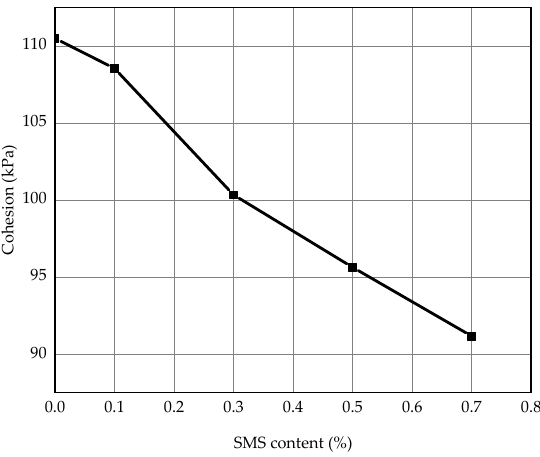
Figure 7. The change of cohesion force with SMS content.